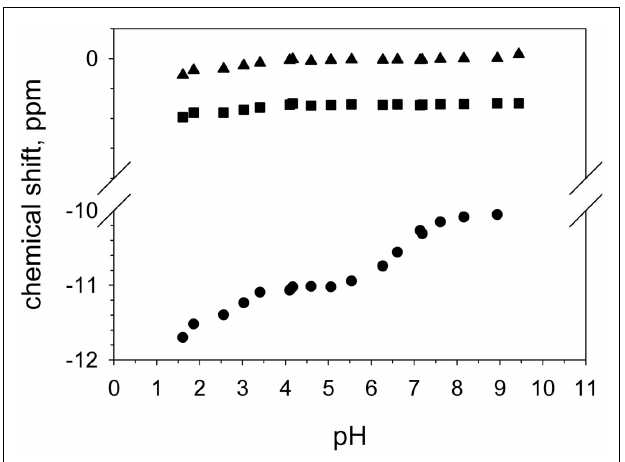
FIGURE 4 | Peak positions of the phosphodiester of DOPE (triangle), DOPC (square), and DGPP (circle) as a function of